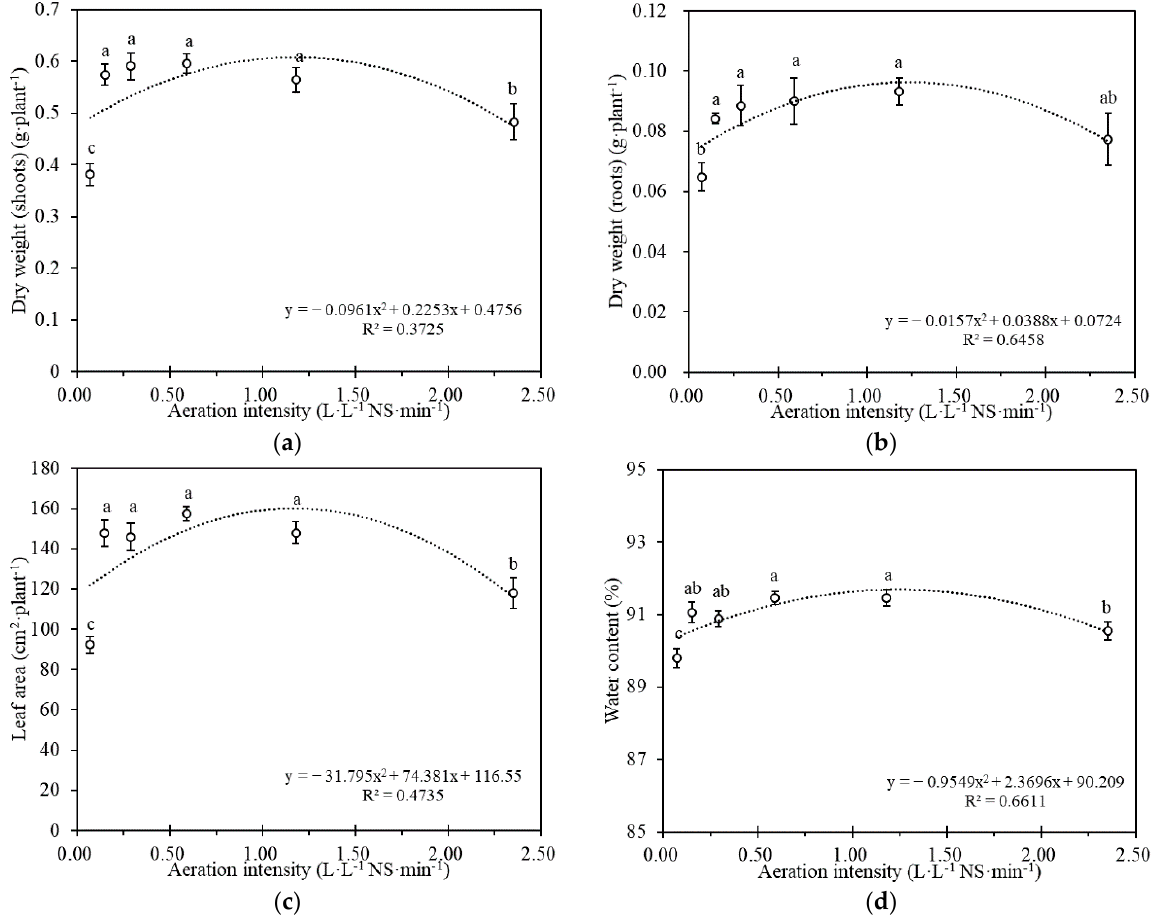
Figure 5. The plant growth and root morphology under different aeration intensities: ( a ) dry weight (shoots), ( b ) dry weight (roots), ( c ) leaf area, and ( d ) water content. Bars labeled with different letters indicate significant differences ( p ≤ 0.05), and data are expressed as MSE ( n = 4).